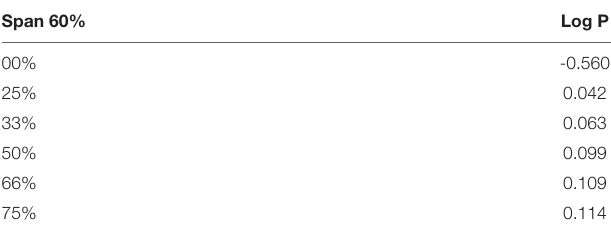
TABLE 4 | Log P values of pure drug and that encapsulated in different % of Span